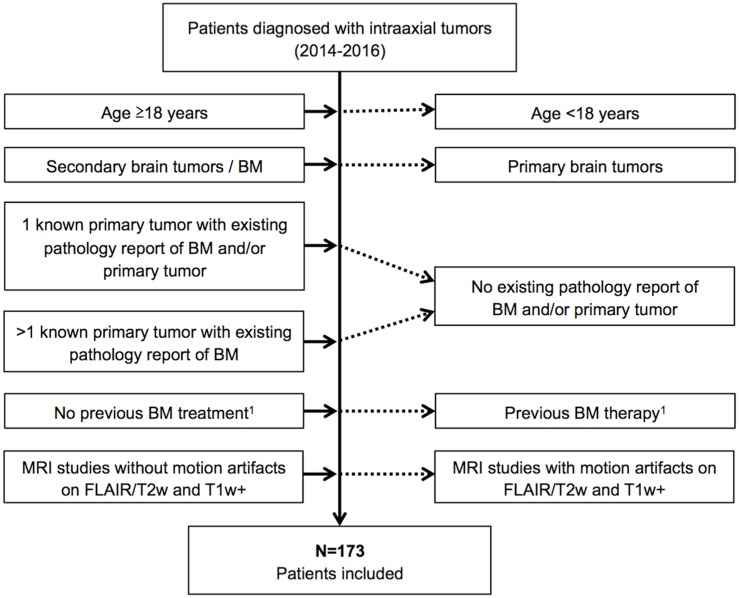
Flow-chart summarizing patient selection in the study.BM = brain metastases, MRI = magnetic resonance imaging.